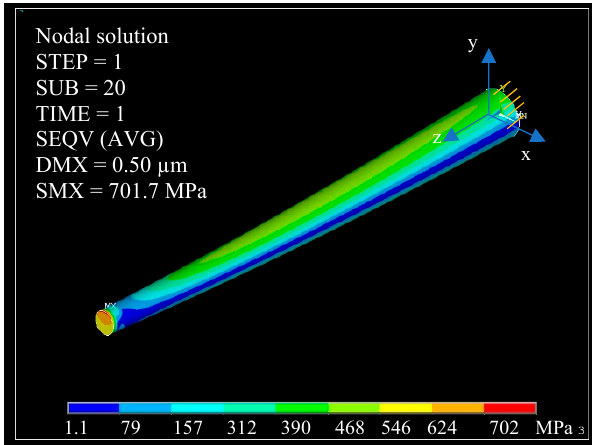
Figure 11. FEM simulation of the pillar No. 1 under maximum deflection (DMX is the maximum deflection of the pillar, and SMX is the maximum stress): The tapered pillar’s bottom surface in x-y plane is fixed. For the FE simulation of silicon pillars, the following anisotropic material constants were employed: E x = E y = 169 GPa, E z = 130 GPa, G xz = G yz = 80 GPa, G xy = 51 GPa, ν xy = 0.062, ν xz = ν = yz